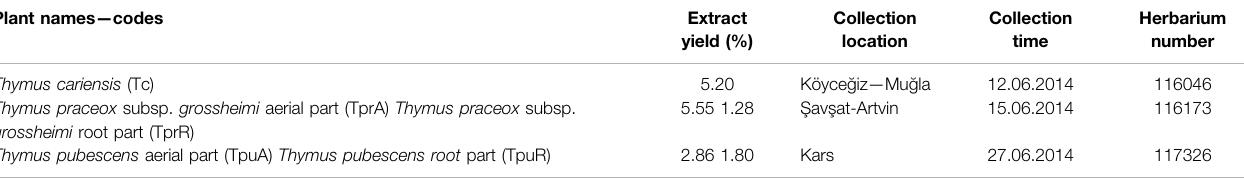
TABLE 1 | Plant names, collection details, herbarium numbers, and extract yield of the studied Thymus